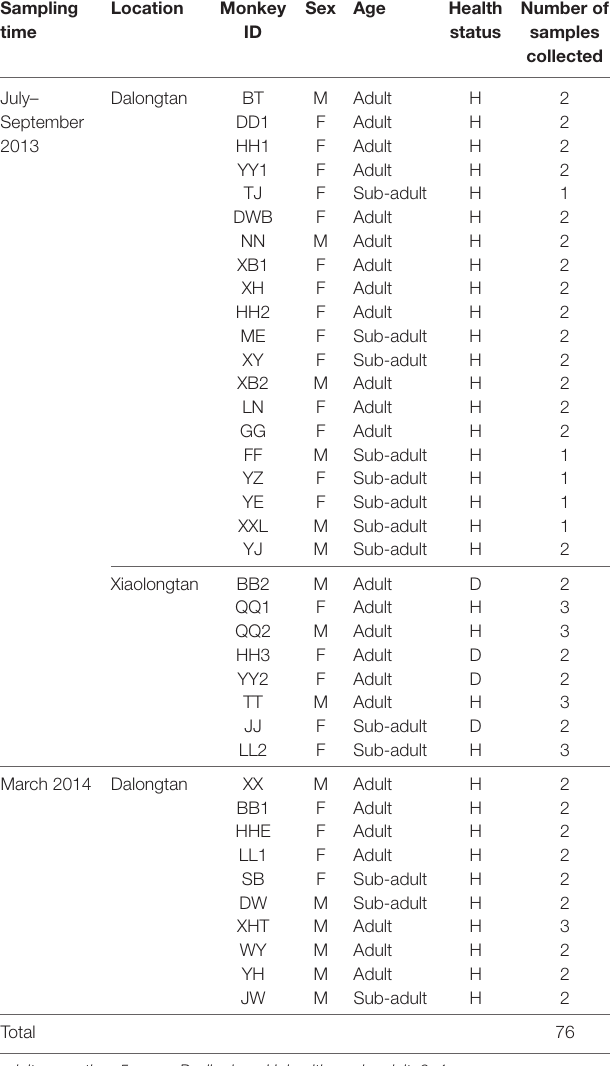
TaBle 1 | Information on golden snub-nosed monkeys with fecal samples. sampling